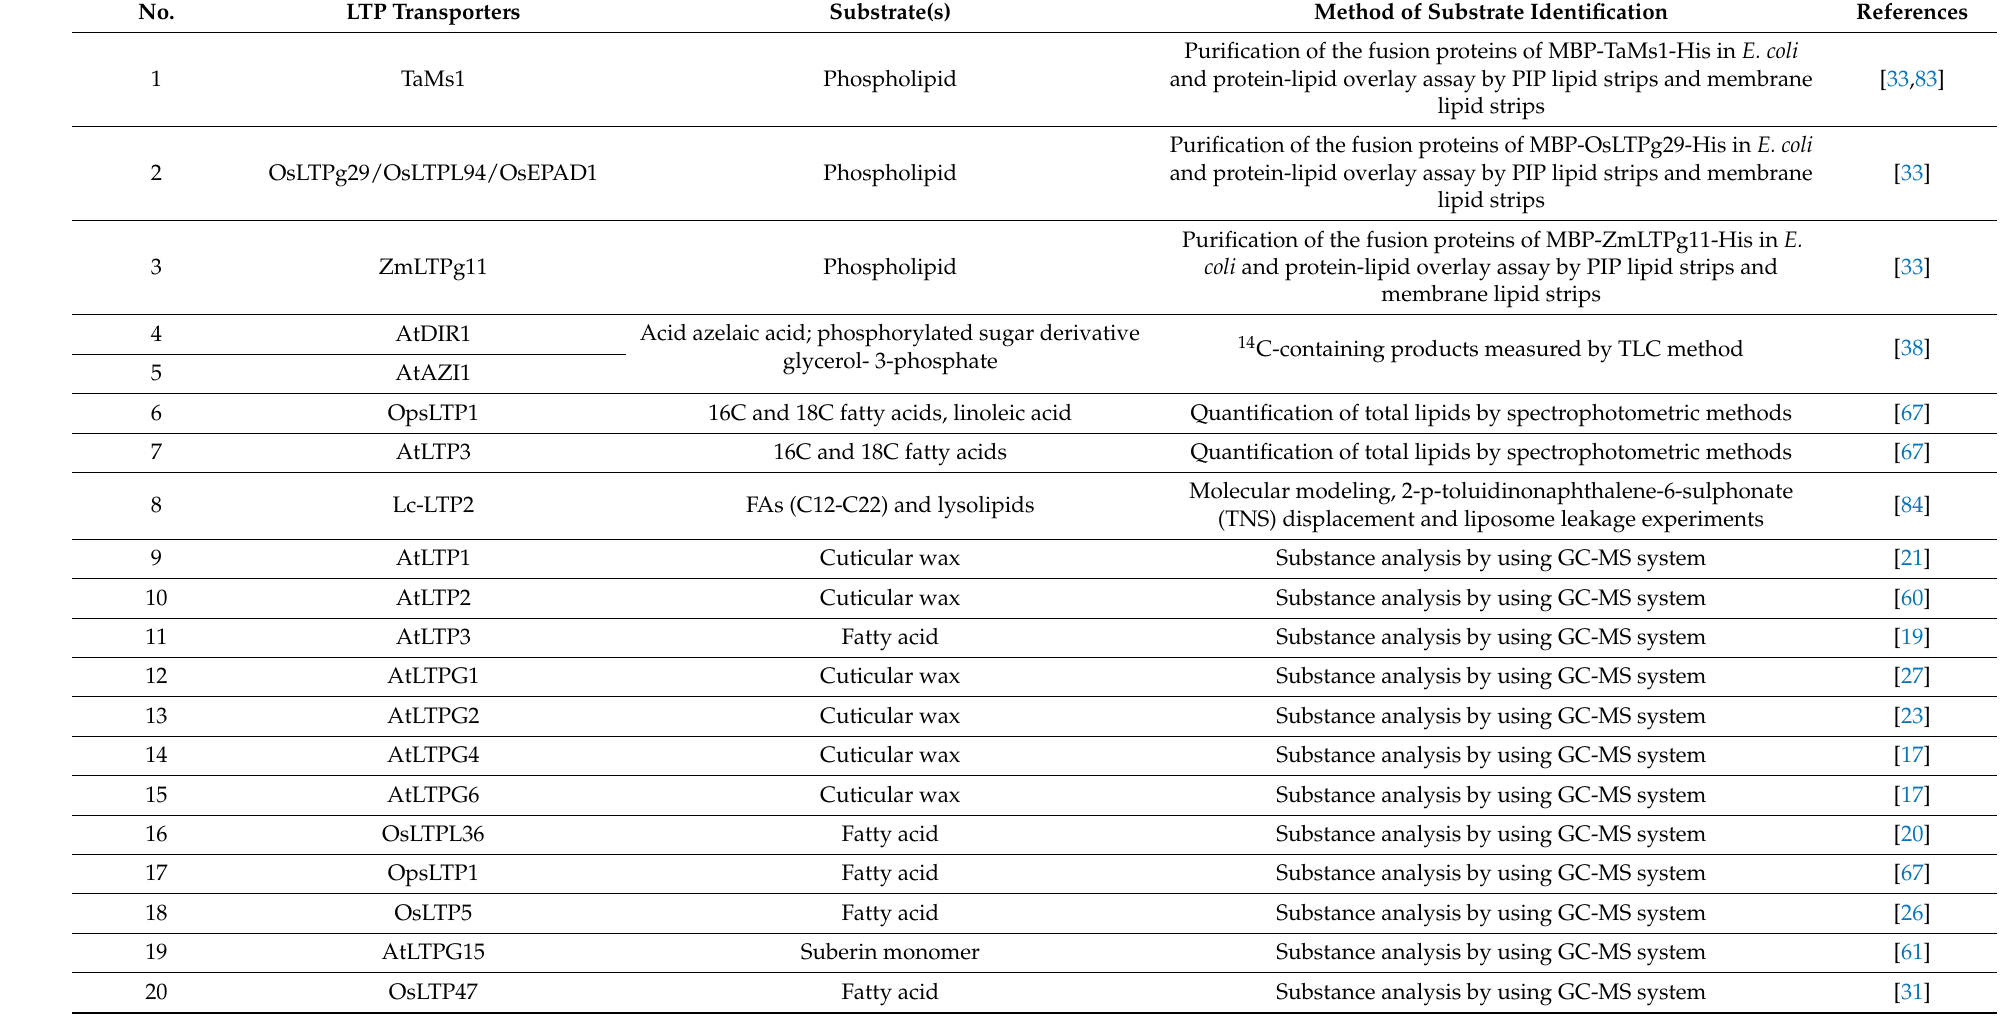
Table 3. The substrate identification of plant LTP